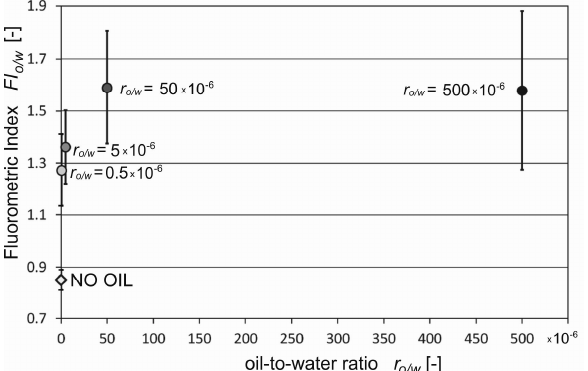
Figure 5. Fluorometric index ( FI o/w ) with standard deviation of the mean for natural seawater (no oil) and seawater artificially polluted by various kinds of oil.